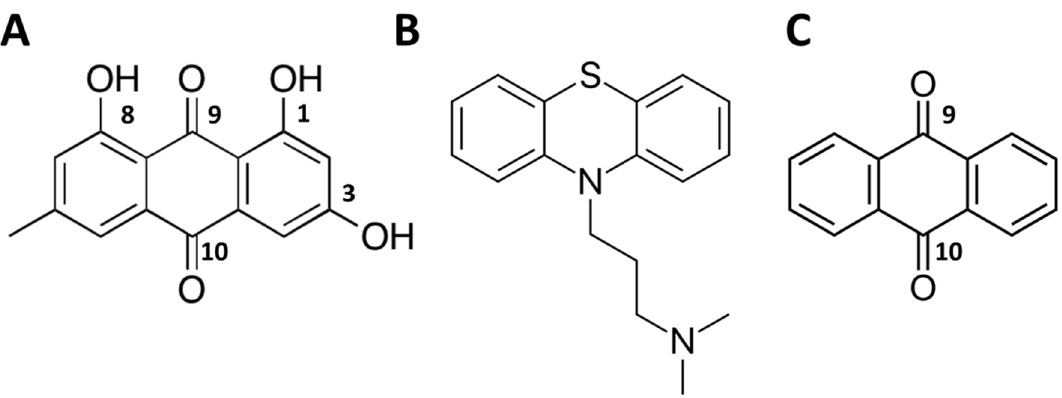
Figure 1. Chemical structure of molecules under analysis. ( A ) Emodin. ( B ) Promazine. ( C ) Anthraquinone.